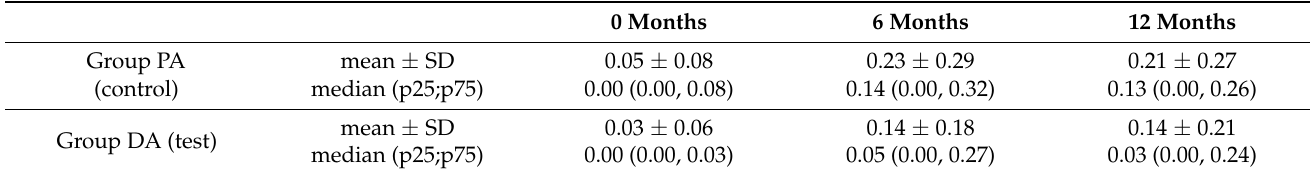
Table 6. Total bone level